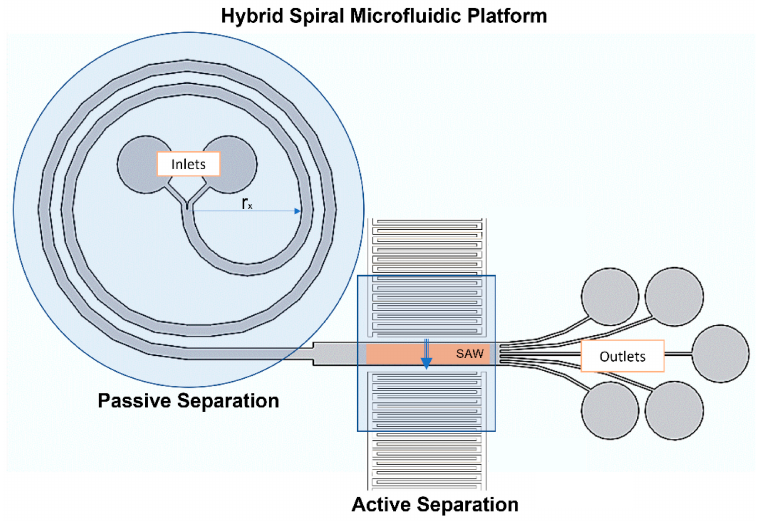
Figure 1. Schematic representation of the hybrid spiral microfluidic platform consisting of passive (spiral) and active (IDTs) components for focusing and separating cells. Table 1. Common geometrical parameters and dimensions of the microchannels which are named as S1, S2, S3, and S4.